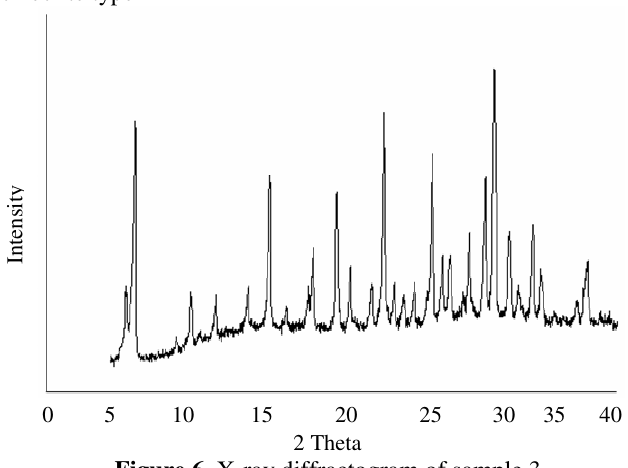
Figure 6. X-ray diffractogram of sample